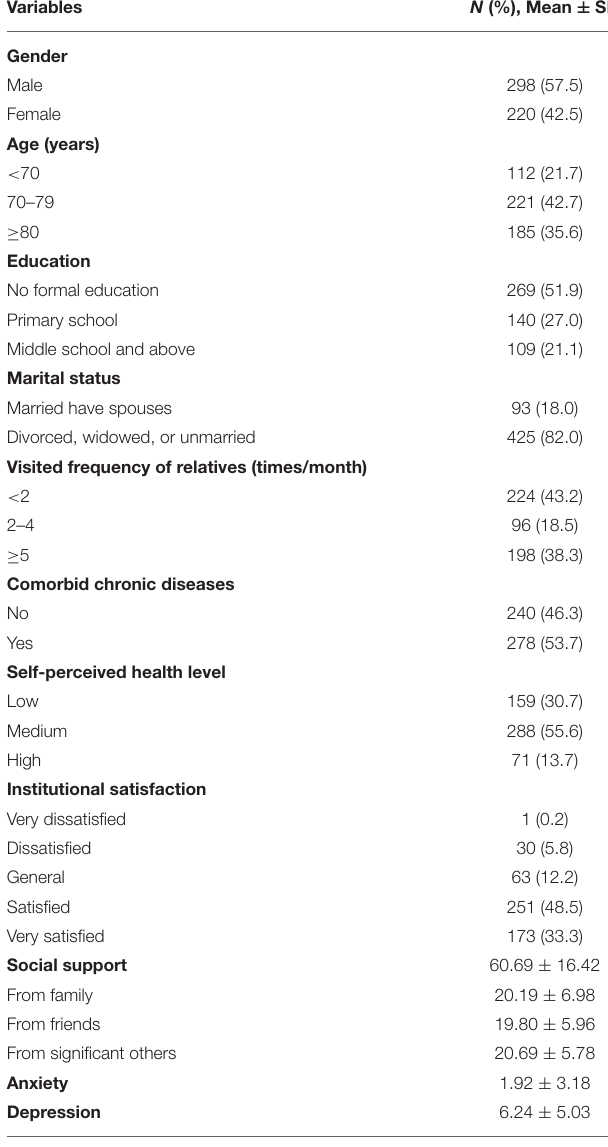
TABLE 2 | Descriptive results of the